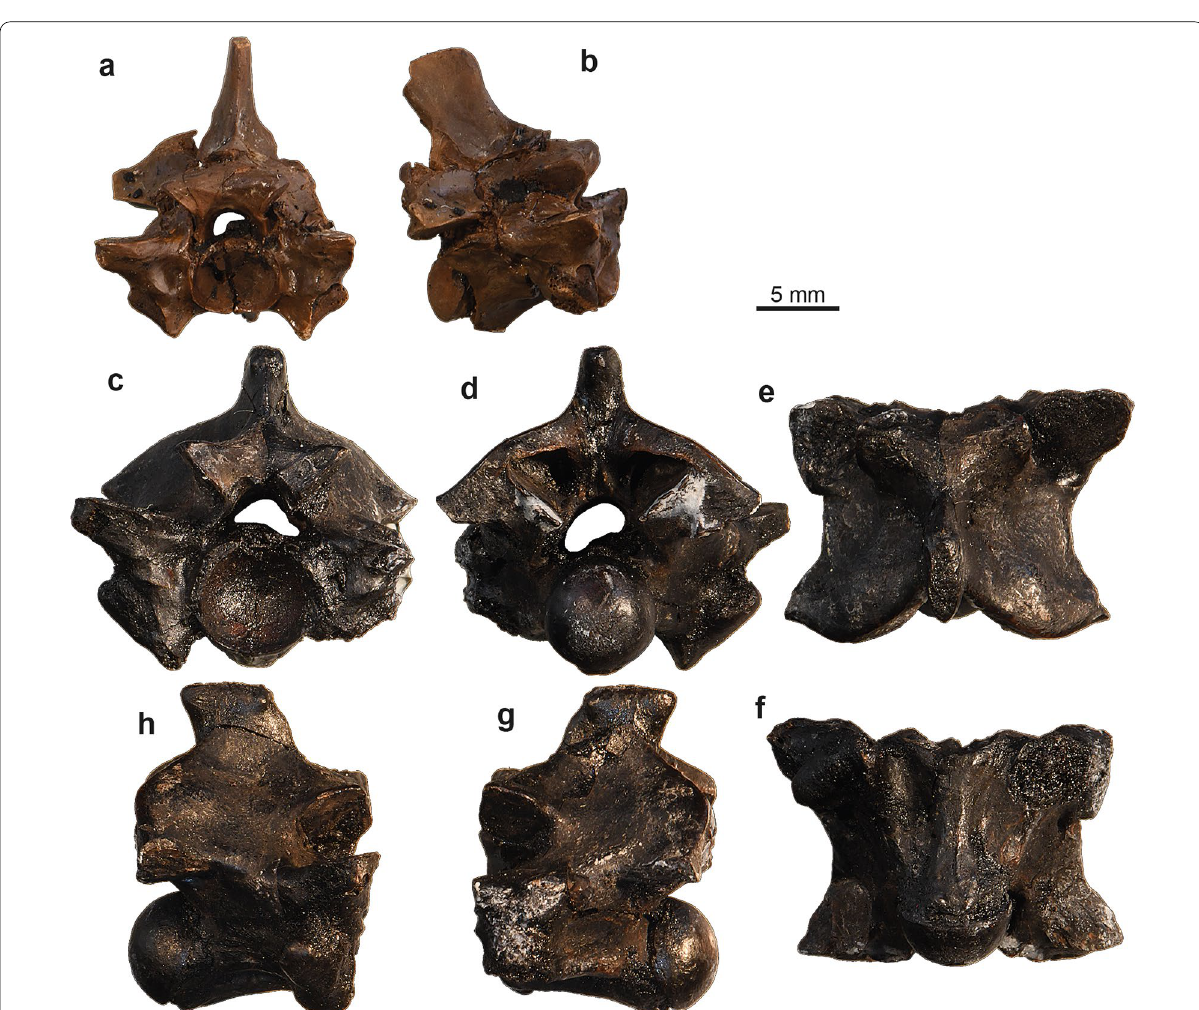
Fig. 65 Eoconstrictor cf. fischeri from quarries Leonhardt III and Cecilie IV, Geiseltal: a , b anterior trunk vertebra (GMH Leo III-2933-1934) in anterior ( a ) and right lateral ( b ) views; c – h posterior mid- or anterior posterior trunk vertebra (GMH Ce IV-2912b-1933) in anterior ( c ), posterior ( d ), dorsal ( e ), ventral ( f ), left lateral ( g ), and right lateral ( h ) views [this specimen was originally referred to as Paleryx spinifer and figured by Kuhn (1939a:pl.